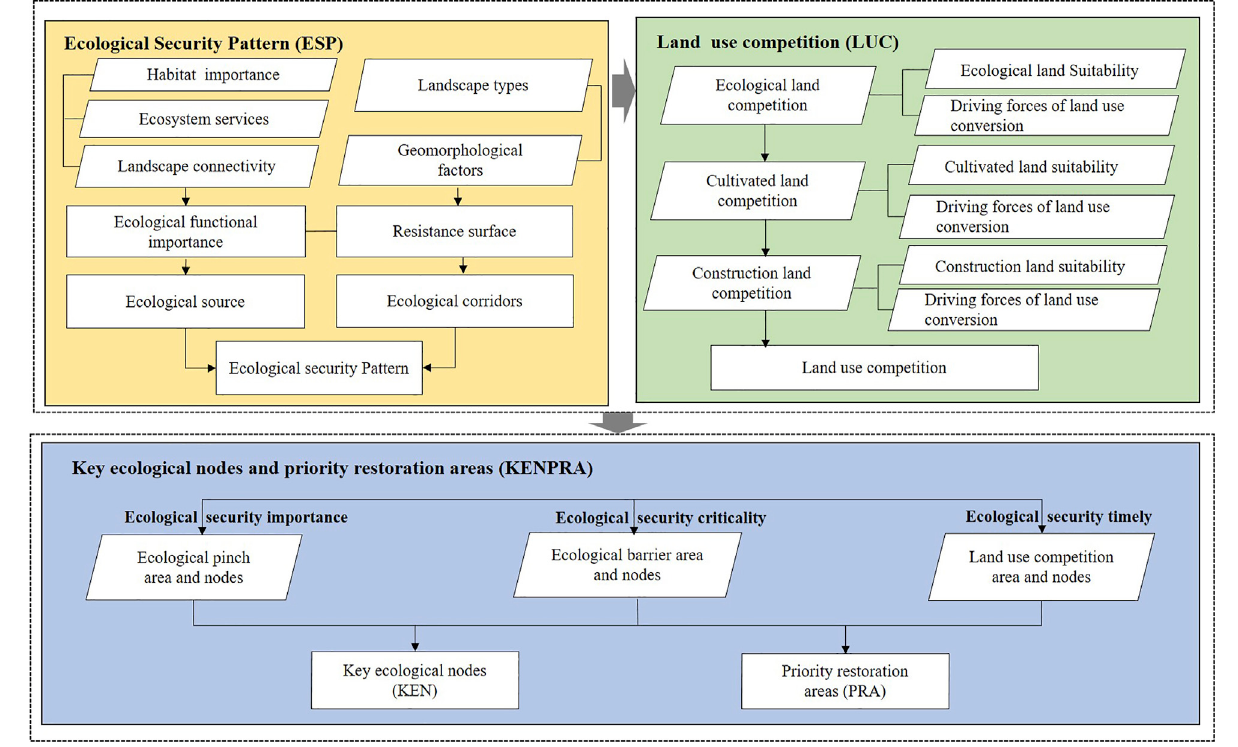
Frontiers in Earth Science |